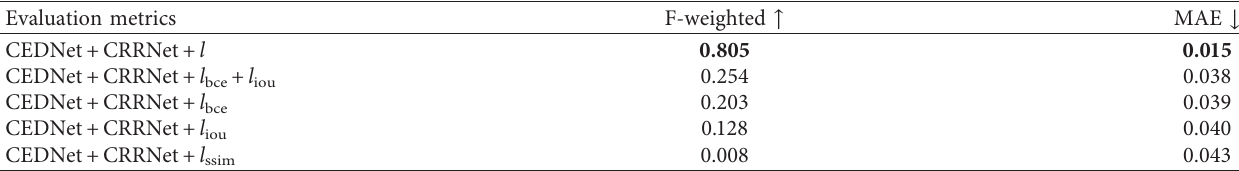
Table 4: Performance comparison of different loss functions.